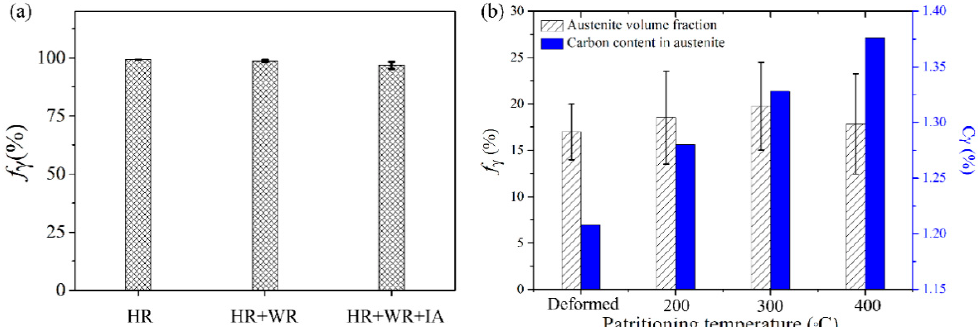
Figure 2. ( a ) The evolution of austenite phase fraction during HR (hot rolling), WR (warm rolling), and IA process (intercritical annealed). ( b ) The phase fraction and increment of carbon content of austenite in Deformed, D&P200, D&P300, and D&P400 samples.